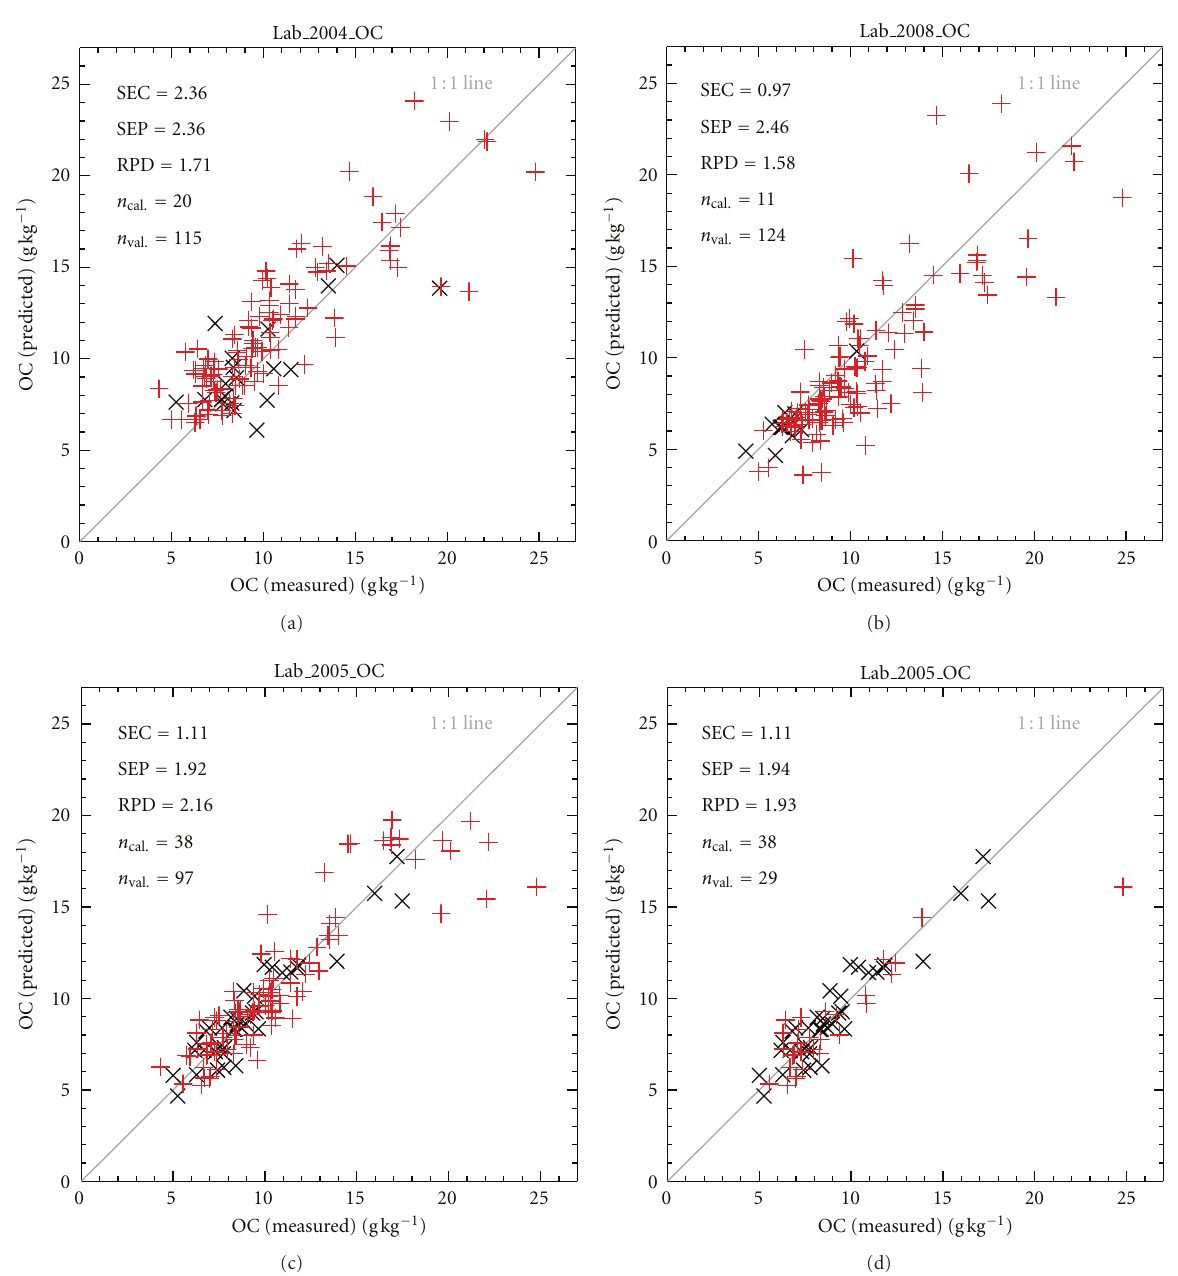
Figure 8: Plots of measured versus predicted values for organic carbon (gkg − 1 ) in the calibration (black symbol, × ) and validation (red symbol, +) data sets based on laboratory spectra. The respective calibration and validation data schemes ( n cal . / n val . ) are marked on the plots. For further explanation see